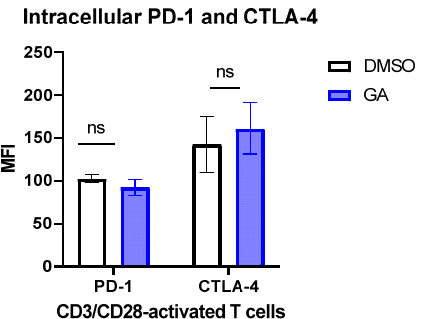
Figure 4. HSP90 inhibition and intracellular PD-1 and CTLA-4 in CD3/CD28-activated T cells. T cells were stimulated for 48 h with anti-CD3/CD28 and hIL-2. At 48 h of incubation, 0.1 µM GA or DMSO was added, and the cells were incubated for an additional 24 h. The graph shows the mean ± SEM. ns, not significant. DMSO, dimethyl sulfoxide; GA, geldanamycin.